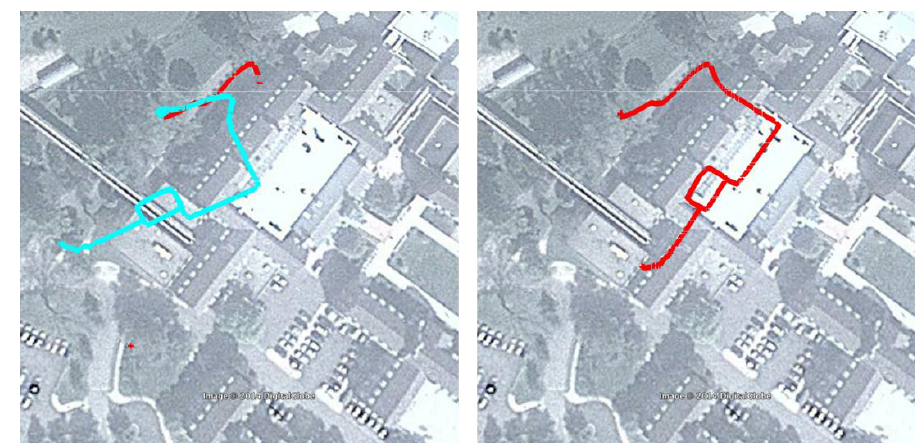
Figure 14. Altitude estimation results.